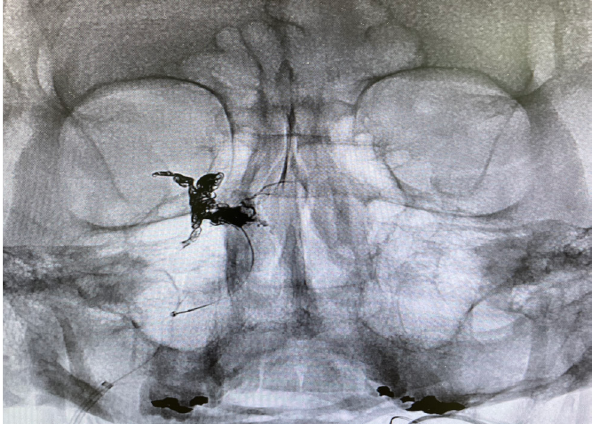
Image 3. Post-operative imaging revealing successful coiling and embolization of the